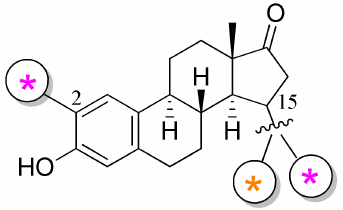
Figure 2. The fluorescent labeling at positions C-2 and C-15 of